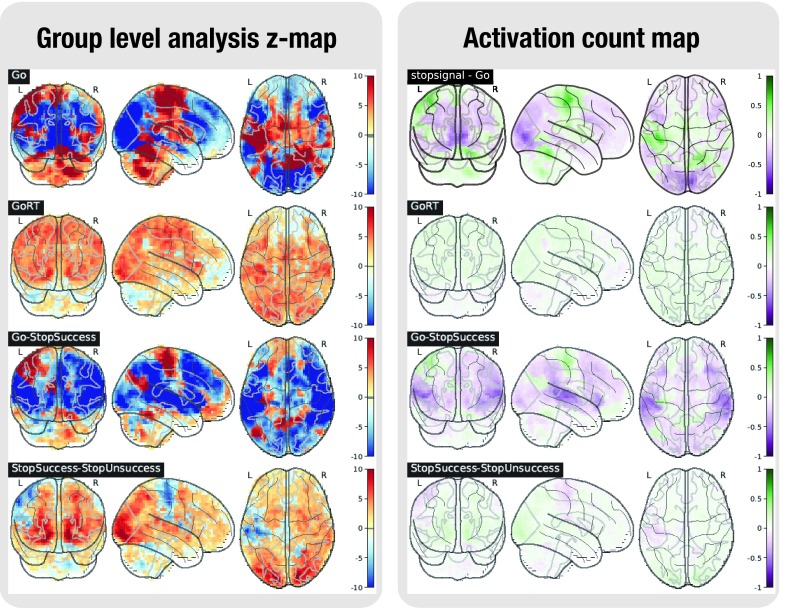
Task analysis results for the STOPSIGNAL task.In the left plot, the statistical map of the one-sample group test, computed with randomise. The right plot shows the difference between the positive and the negative activation count maps.